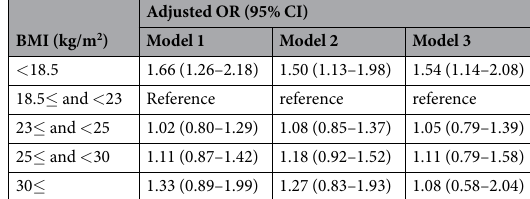
Table 2. Multivariate analysis of the association between tinnitus and BMI. Odds ratios (ORs) and 95% confidence intervals (CIs) for the presence of tinnitus in premenopausal women. Model 1 = Nonadjusted. Model 2 = Model 1 + adjusted for age, smoking, drinking, exercise. Model 3 = Model 2 + adjusted for perceived stress, melancholy, duration of